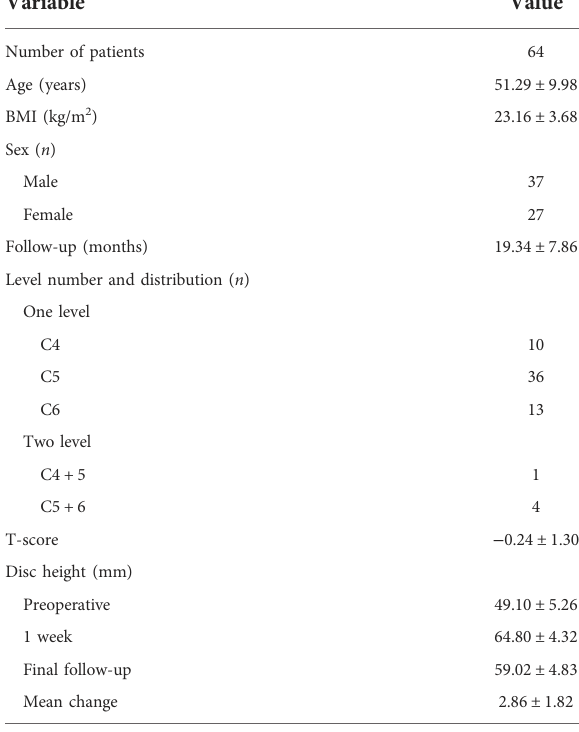
FIGURE 2 Measurement method of the global and segmental cervical curvature. The C2 – 7 angle was de fi ned as the angle between the caudal margin of C2 and the caudal margin of C7 in a neutral position. The segmental angle was de fi ned as the angle formed by lines drawn at the cranial margin of the upper instrumented vertebral body and the caudal margin of the lower instrumented vertebral body.